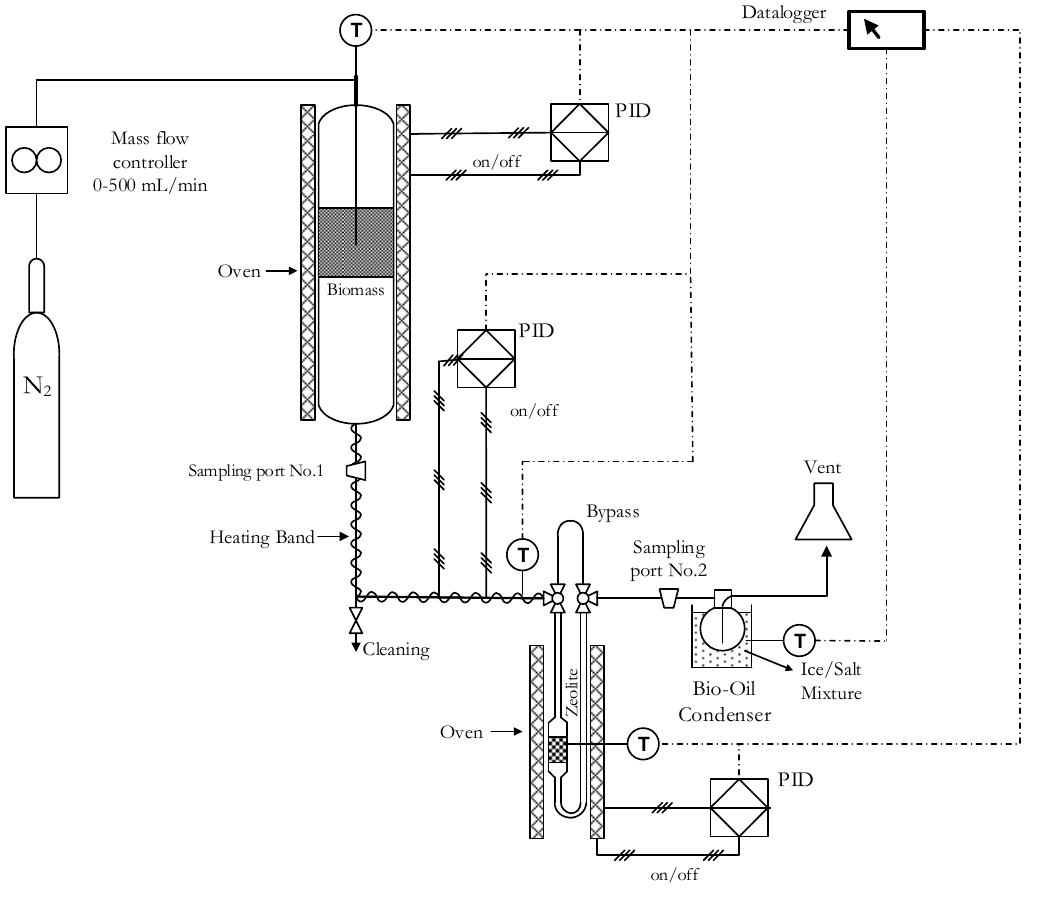
Figure 3. Experimental setup.